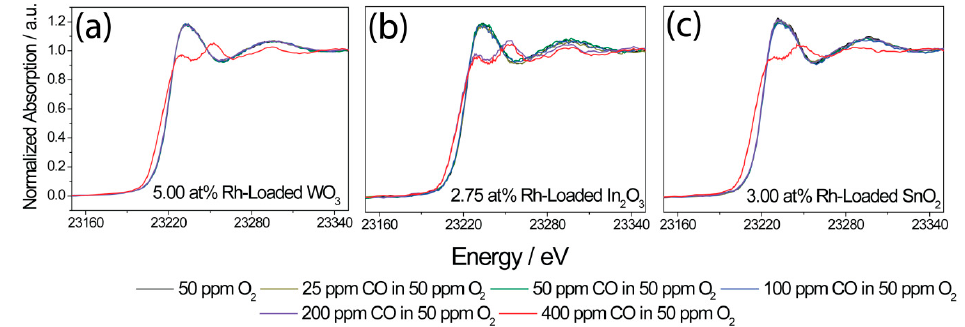
Figure 12. Rh K-edge XANES spectra of 5.00 at.% Rh-loaded WO 3 ( a ), 2.75 at.% Rh-loaded In 2 O 3 ( b ), and 3.00 at.% Rh-loaded SnO 2 ( c ), recorded during different CO exposures in a low-oxygen background (50 ppm O 2 ) at 300